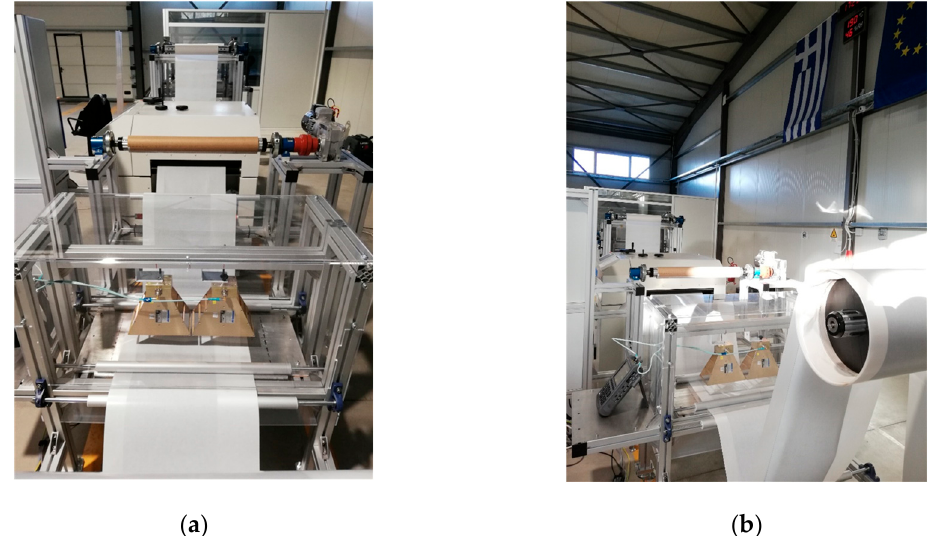
Figure 4. ( a ) A front and ( b ) an isometric view of the R2R pilot line with the free space antenna system integrated.